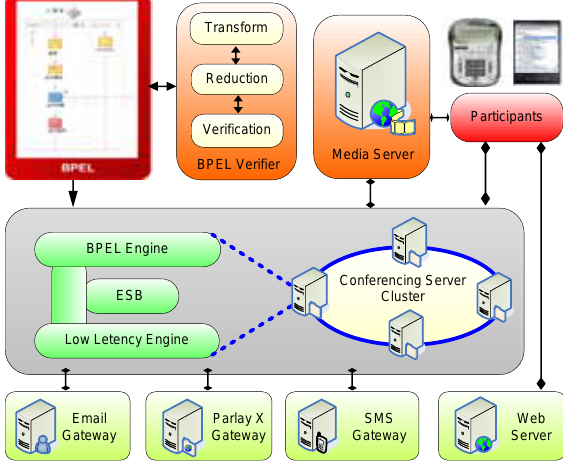
Fig.21. Conference notification services